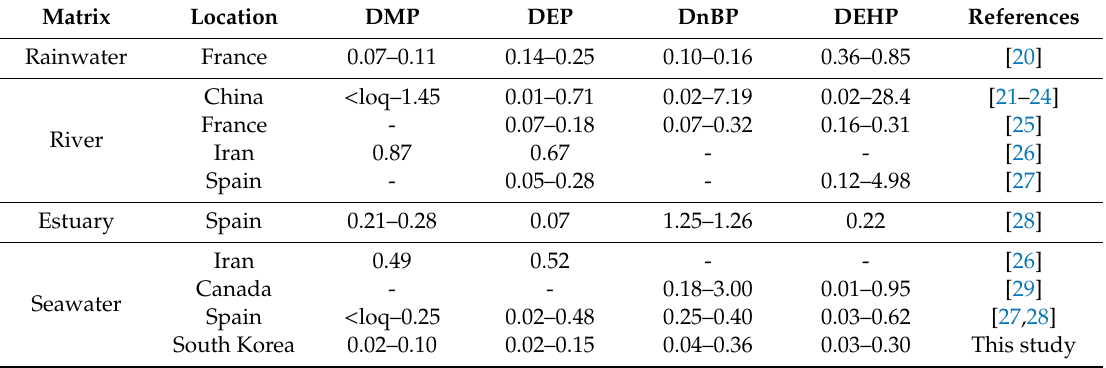
Table 4. The concentrations of the four phthalate esters (PEs) in various aquatic environments ( µ g / L). Matrix Location DMP DEP